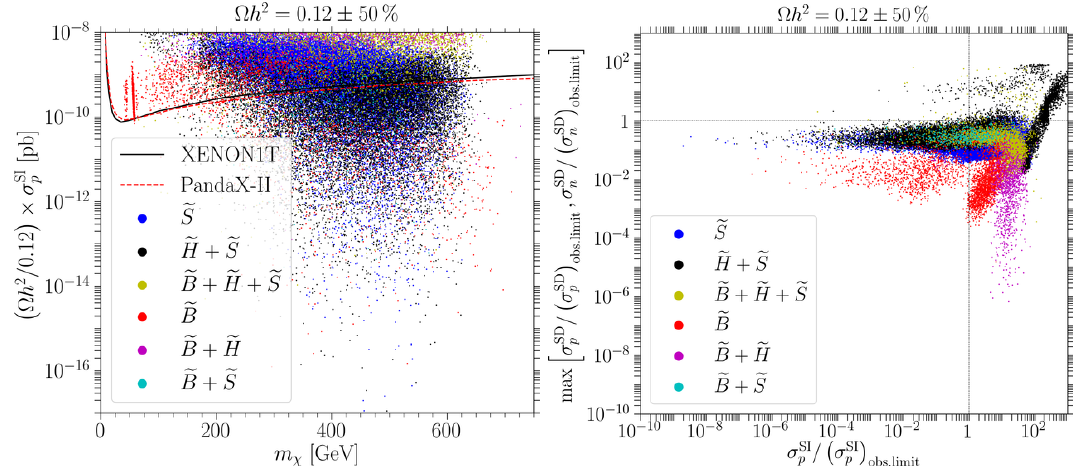
Figure 7 . Left: the SIDD cross section vs. the mass of the DM candidate m (cid:31) for points from our parameter scan passing the required experimental collider constraints with acceptable relic density (cid:10) h 2 = 0 : 12 (cid:6) 50 %. The solid black and dashed red lines indicate the most constraining experimental upper limits on the SIDD cross section from XENON1T [3] and PandaX-II [4], respectively. Right: SIDD vs. SDDD cross section in units of the respective observed limit for the same points. For SIDD cross section, at each respective DM mass we use the stronger of the two limits from XENON1T and PandaX-II. For SDDD scattering we use the more constraining of the current bounds for either SDDD scattering of neutrons from LUX [5], or SDDD scattering of protons from PICO-60 [6]. To guide the eye we indicate the current bounds with thin dashed lines; points lying in the lower left quadrant satisfy all current direct detection bounds. The color coding in both panels is the same as in (cid:12)gure